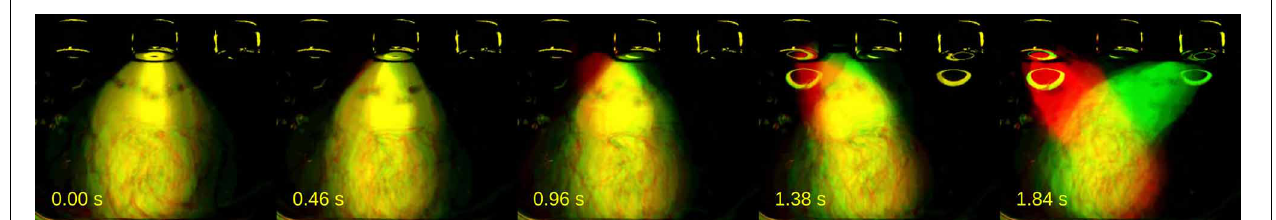
FIGURE 4 | Distinct behaviors accompany different categorizations of same stimulus. A series of video frames were taken from a representative session of rat Edgar at specific time points during presentations of a